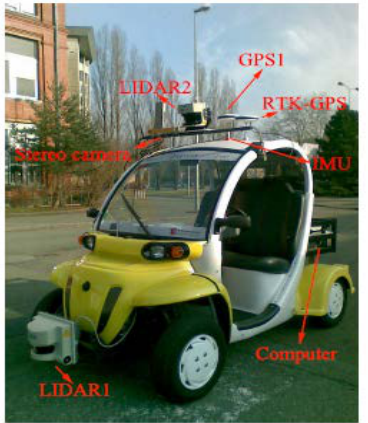
Figure 4. The experimental vehicle equipped with sensors (camera and RTK-GPS).